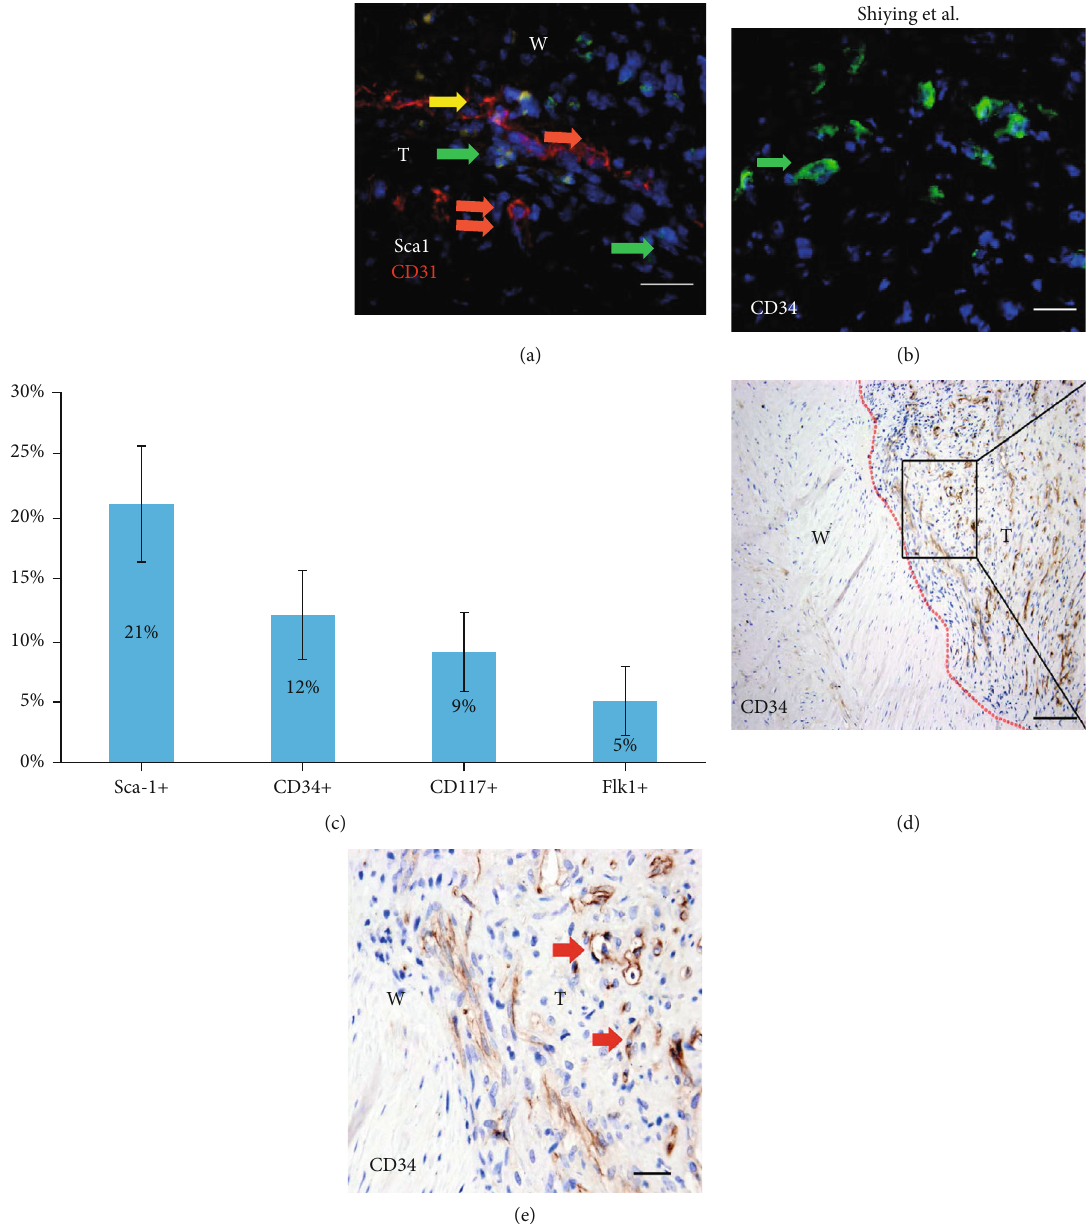
Figure 2: Progenitor cells in the thrombi. (a) The result of double staining with Sca1 antibody and CD31 in the 7-day thrombi of mice. The green arrow indicates Sca1 + progenitor cells in the venous thrombi. The red arrow indicates CD31 + endothelial cells in the intima of venous wall. The double red arrows indicate CD31 + endothelial cells of neovascularization within the marginal area of thrombi. The yellow arrow indicates crossing of Sca1 + progenitor cells into the endothelial cells within the intima of venous wall. (b) The labeled cells with CD34 antibody in mice. (c) Total cells and positive cells were counted under the microscope. The percentage of progenitor cells in the marginal area of thrombi from 5 mice. (d, e) The result of staining with antibody CD34 in a 25-day thrombus of HGSV. The red dotted line indicates the intima of the vein. The red arrow indicates CD34 + cell in thrombus. T: area of thrombi; W: area of vein wall. Scale bars: 25 μ m (a, b); 100 μ m (d); 50 μ m